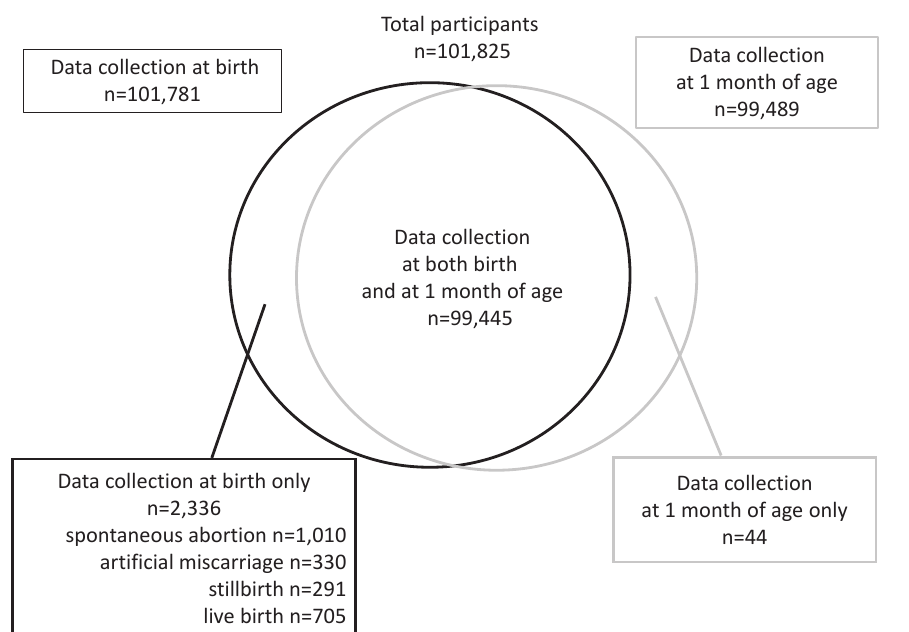
Figure 1. Venn diagram of congenital anomaly data collected from information entered in the medical records at delivery and at 1 month of age.